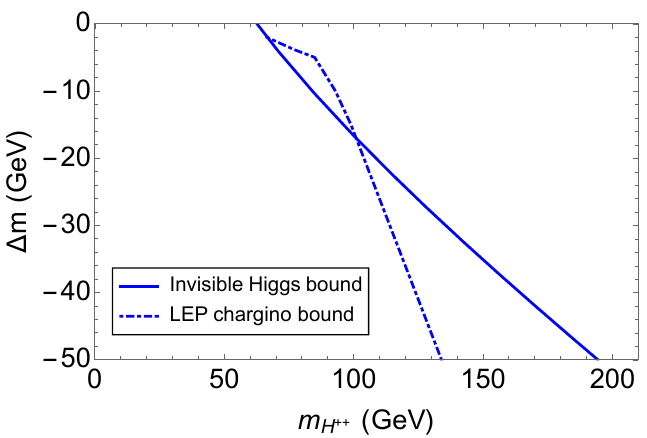
4 GeV from invisible Higgs branching fraction [94–97] and the Figure 7 . The bounds for v = 10 − t LEP chargino searches [102]. The region on the left of each line is